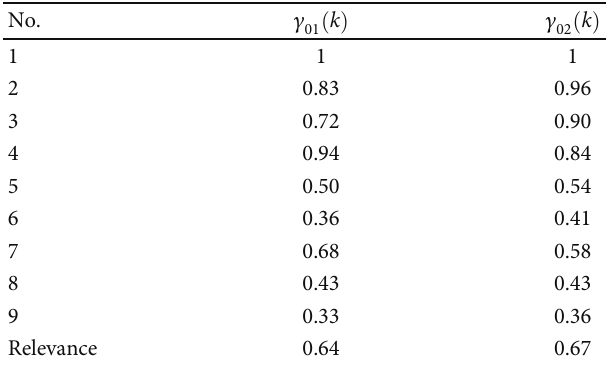
Table 6: Three point fl exural strength correlation coe ffi cient